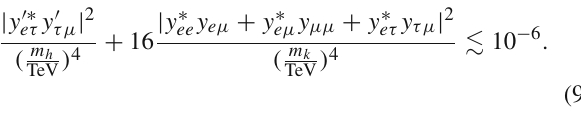
Fig. 1 Summary plot of the upper limits. The blue bars illustrate the robust, model-independent and conservative upper limits from neutrino masses. If two upper limits are provided for a given particle in Table 1, we use the most conservative one. The horizontal red lines indicate the upper limits from Higgs naturalness. Hatching indicates parameter space excluded by non-observation of B -violating nucleon decays. In ordertoillustratethecurrentcolliderlimits,weshowcurrentlimitsfrom